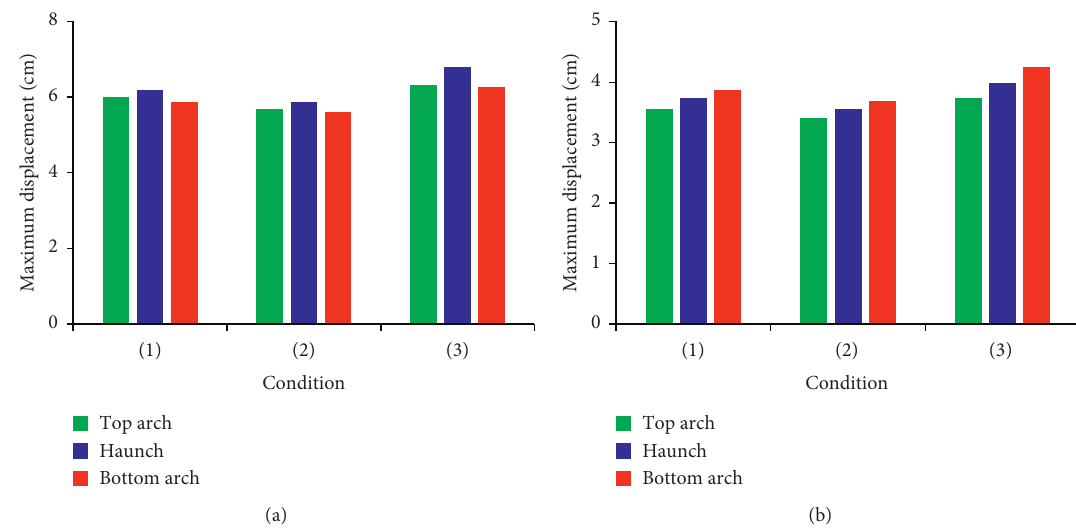
Figure 6: Maximum displacements of monitoring points. (a) x -direction. (b) z -direction.